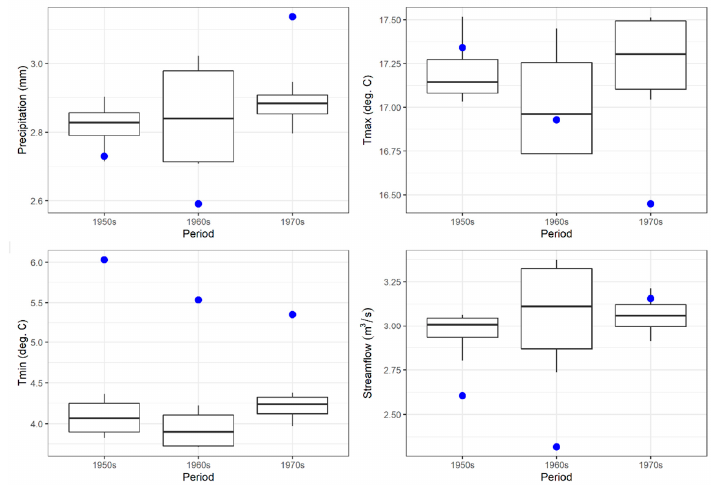
Figure A3. Comparison between observed and GCM simulated precipitation, maximum temperature (Tmax), minimum temperature (Tmin), and streamflow. The observed values are illustrated as the blue circle and the box and whisker plot represents the GCM simulated results and the range of variability between four GCMs. Comparisons are conducted for 3 periods of 10-year interval (1950s = 1951–1960, 1960s =1961–1970, 1970s = 1971–1980).